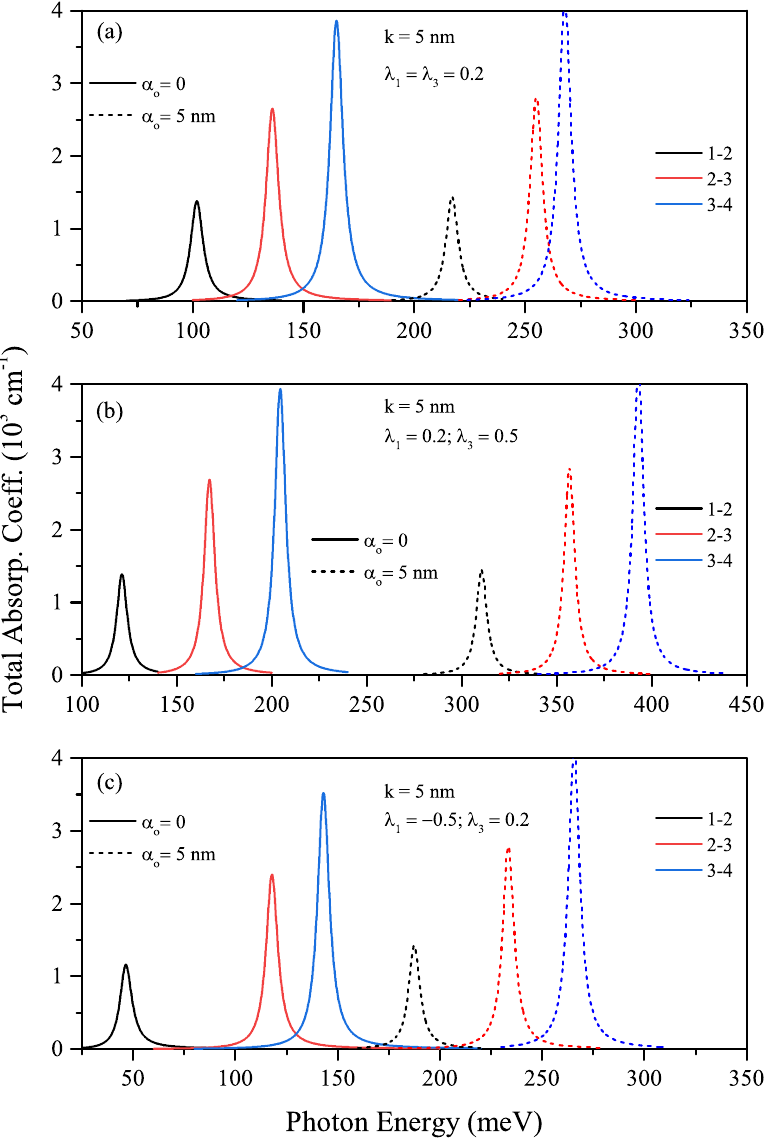
Figure 8. The variations of total absorption coefficients as a function of the incident photon energy for k = 5 nm: the sextic single AHO for λ 1 = λ 3 = 0.2 ( a ), λ 1 = 0.2, λ 3 = 0.5 ( b ), and to the sextic double AHO for λ 1 = − 0.5, λ 3 = 0.2 ( c ),